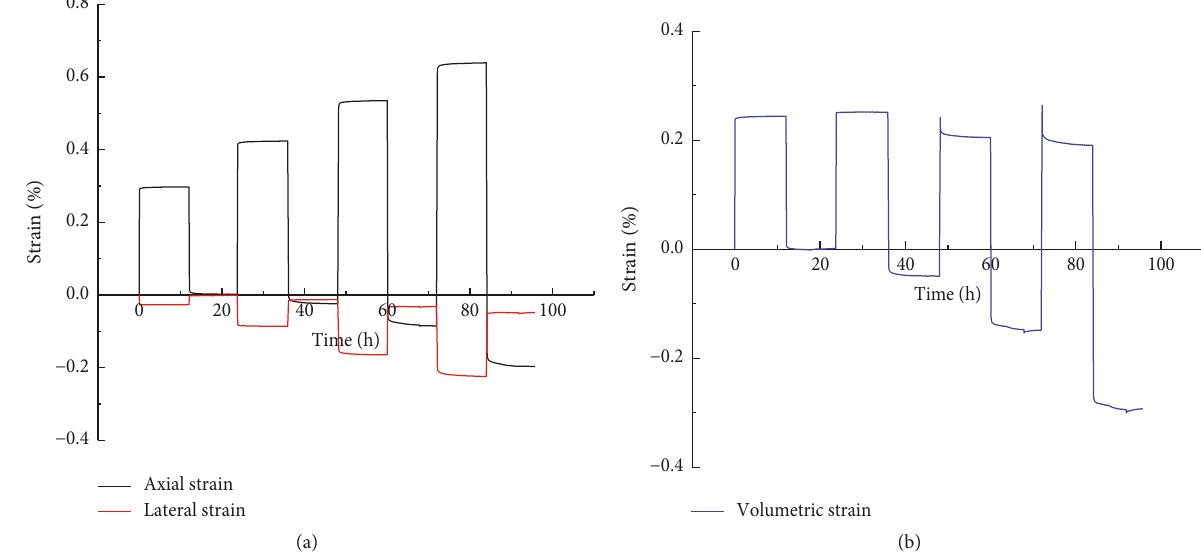
Figure 11: Curves of strain versus time of sandstone specimens under cyclic compressive and tensile stress: (a) axial and lateral strain and (b) volumetric